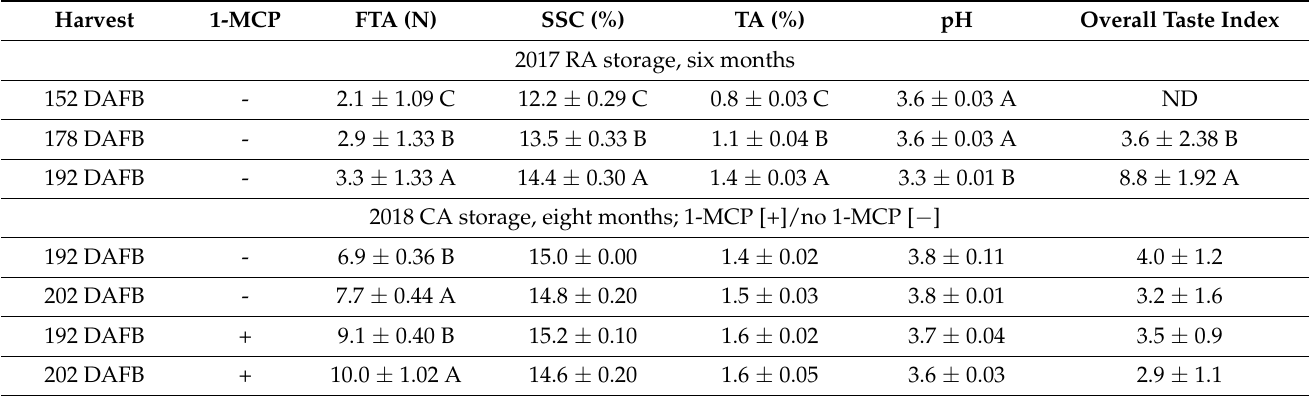
Table 2. Ripening indices (mean ± SE) of kiwifruit after shelf life, following six months of RA storage (2017) and eight months of CA storage with and without 1-MCP